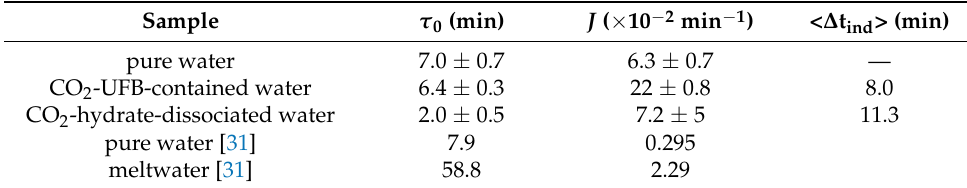
Table 2. Nucleation probability